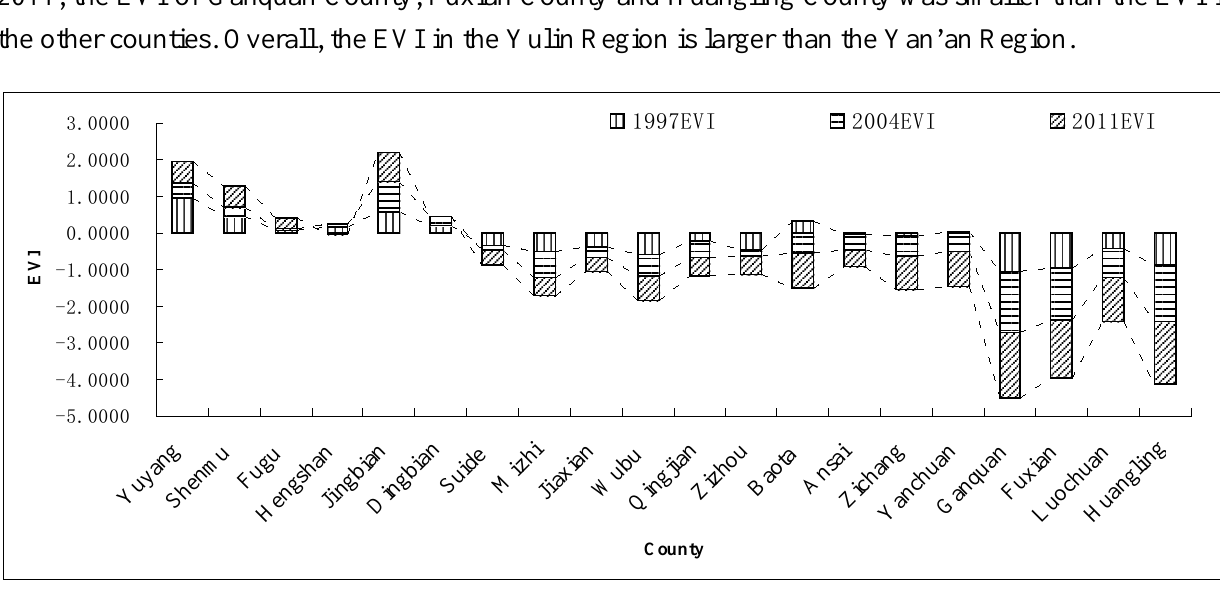
Figure 2. The ecological vulnerability of Northern Shaanxi in 1997, 2004 and